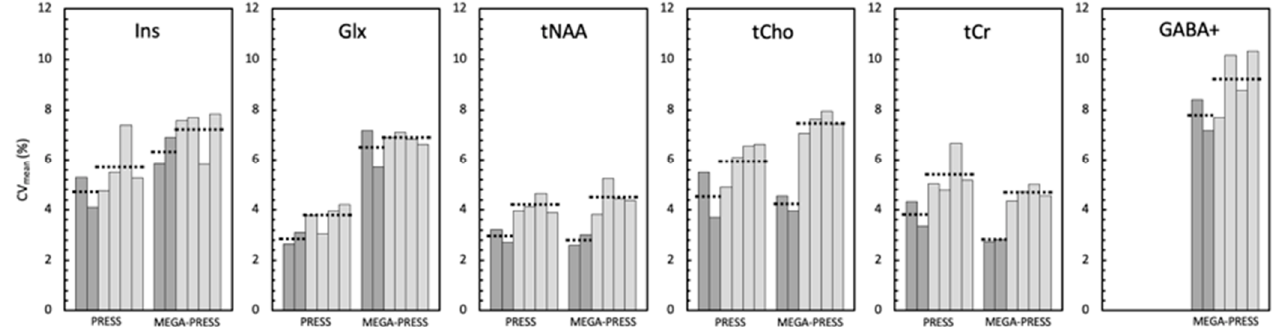
Figure 3. Bar graphs show the CV% of B2B and D2D pairwise comparison across PRESS and MEGA-PRESS for standard metabolites and GABA+. Each bar is an average CV% value across subjects (PRESS n = 17; MEGA-PRESS n = 25–27). Dark grey bars represent B2B measurements (Day1 and Day2). Light grey bars represent D2D measurements (from left to right, D1S1D2S1; D1S2D2S2; D1S1D2S2; D1S2D2S1) (D is Day, S is Session). Horizontal dotted lines indicate mean of the two B2B CV% and mean of the four D2D CV% for easier visualization. Values are given in Tables 2 and 3 and Supplementary Tables S1 and S2.